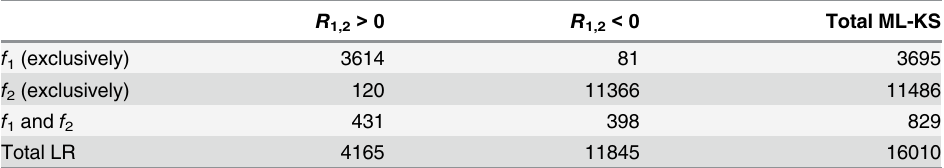
Table 1. Number of texts fitted by f 1 , f 2 or